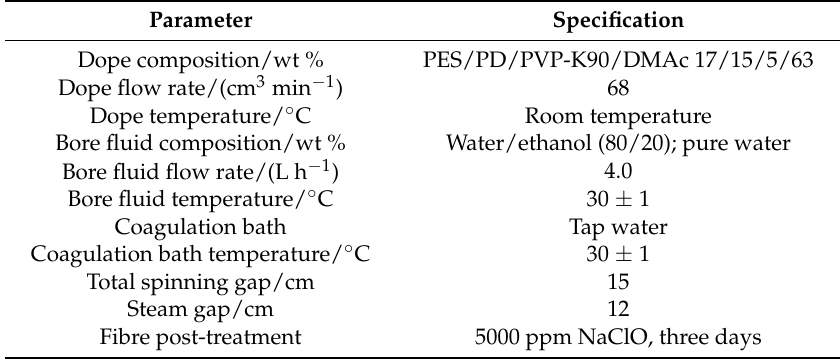
Table 1. Dope composition, spinning parameters and post-treatment of produced MCM.